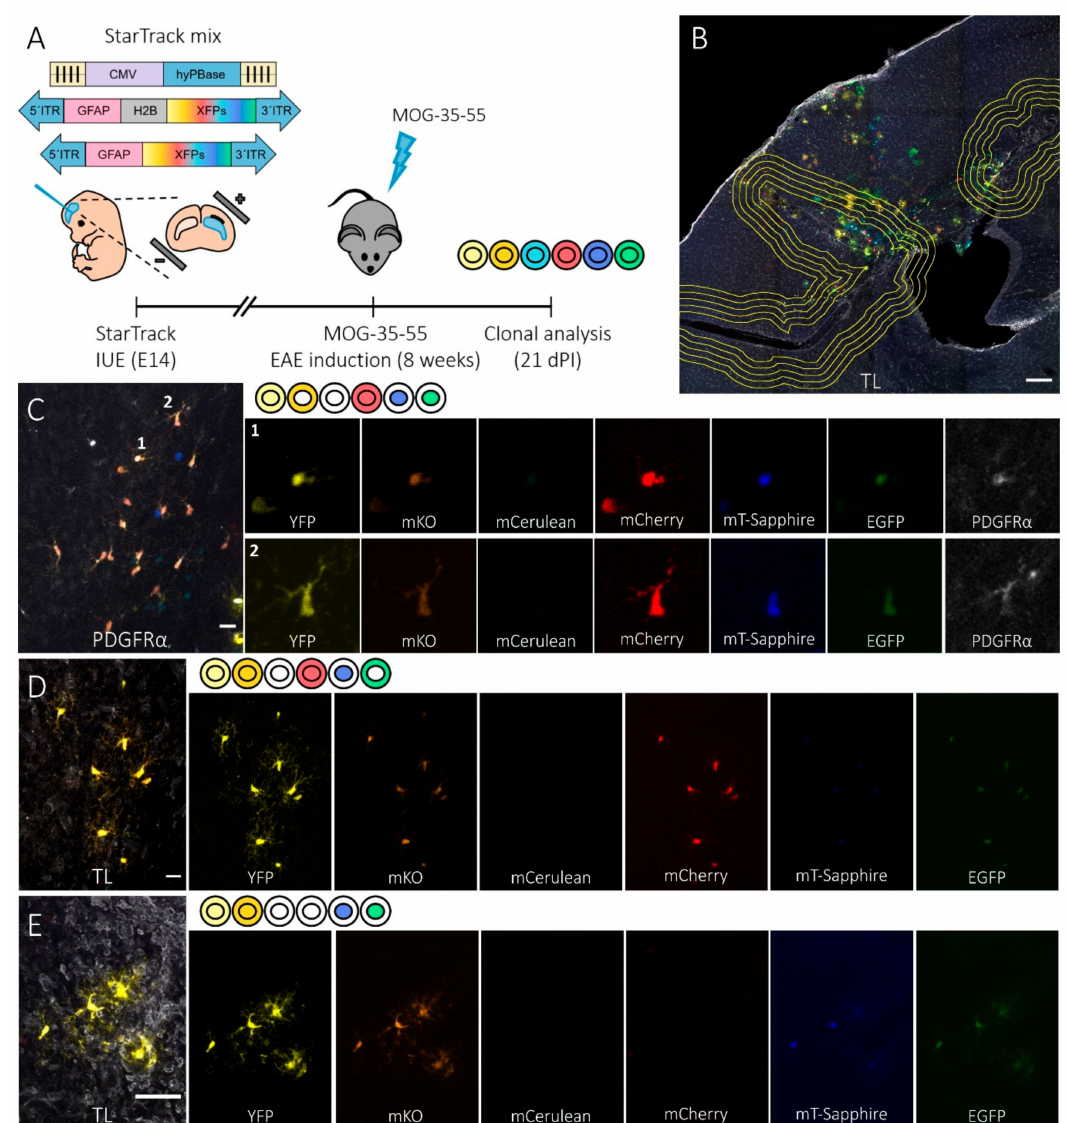
Figure 1. StarTrack-labelled NG2-glia progeny of individual dorsal subventricular zone (SVZ) progenitors after the induction of EAE. ( A ) Time-line showing the experimental approach: in utero electroporation (IUE) of the StarTrack mix into E14 dorsal neural progenitor cells (NPCs) in the lateral ventricle (LV), induction of experimental autoimmune encephalomyelitis (EAE) in mice eight weeks after electroporation, and clonal analysis 21 days’ post-induction (dpi). The StarTrack mixture contained a hyperactive PiggyBac transposase (hyPBase) and 12 plasmids that encoded six di ff erent fluorescent proteins (XFPs) expressed in either the nucleus or cytoplasm. A glial fibrillary acidic protein (GFAP) promoter drove XFP expression. ( B ) Coronal view of the brain showing the location of EAE lesions in the cerebral cortex, corpus callosum, and striatum, as identified by tomato lectin (TL) labelling. A line surrounding the lesion core and four concentric compartments separated by 50 µ m was used to measure the distance of the NG2-glia sibling cells from the lesion. StarTrack-labelled both astrocytes and NG2-glia around the di ff erent lesion sites. ( C – E ) Detail of the coronal views of sibling NG2-glia dispersed throughout the corpus callosum ( C ) and cerebral cortex ( D , E ). The color-codes and the corresponding XFPs expressed are detailed at the side of the merged images. NG2-glia were identified by platelet-derived growth factor (PDGFR α + ) staining ( C : 1 and 2), TL was used to identify the EAE a ff ected and lesion areas ( E ), and the non-a ff ected zones ( D ). Scale bars, 200 µ m ( B ) and 20 µ m ( C – E